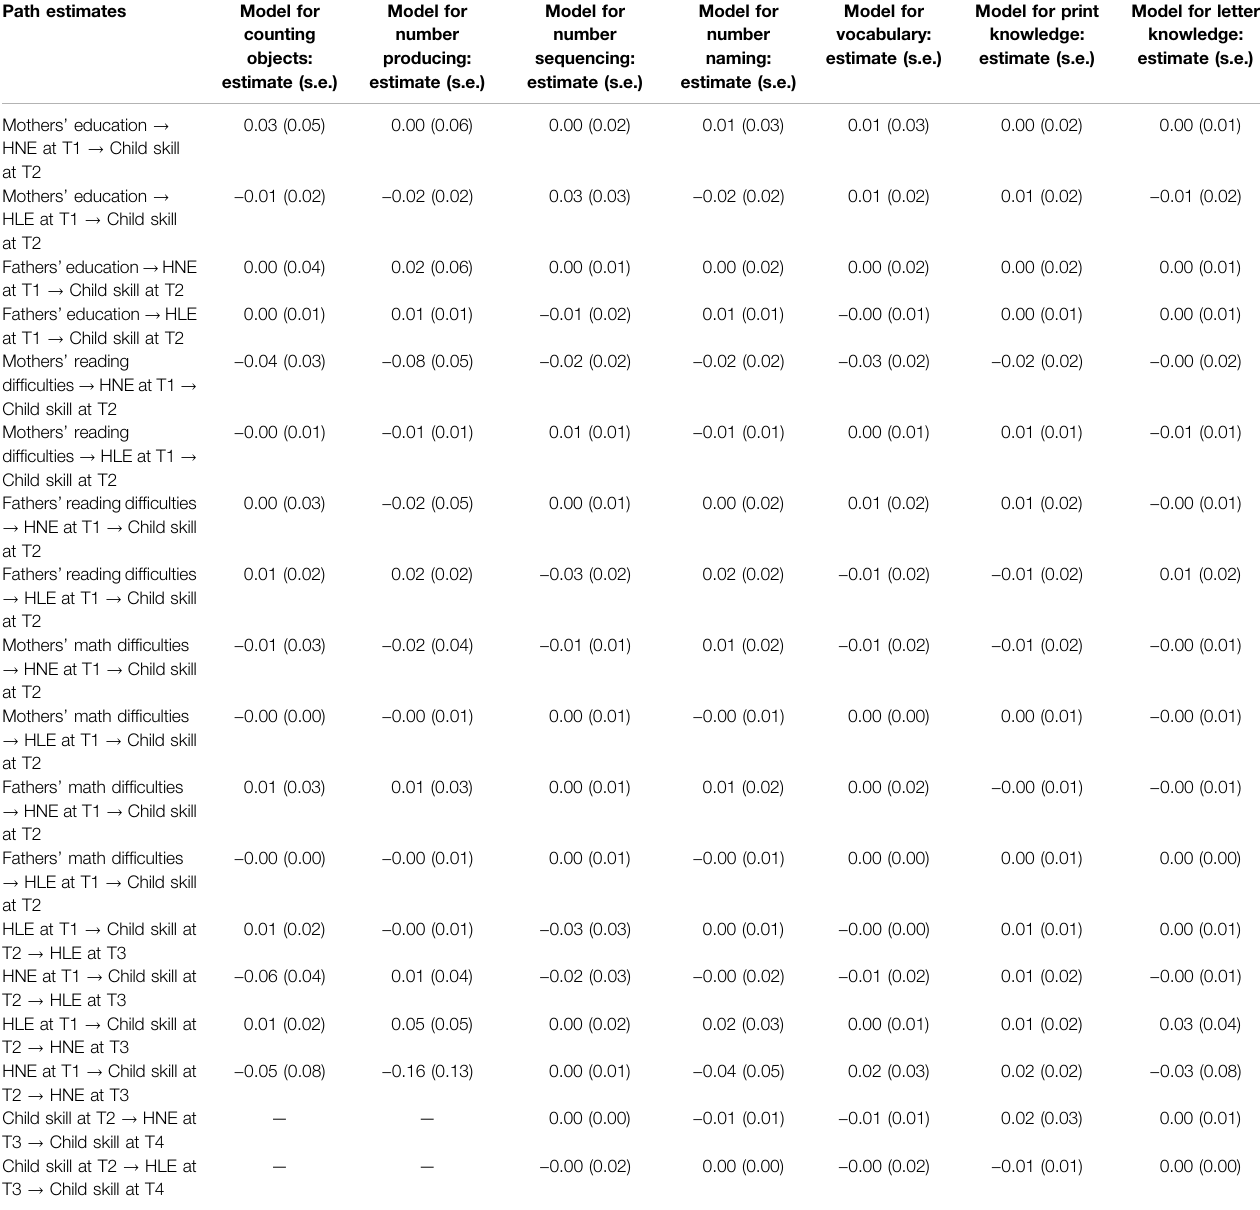
TABLE 5 | All indirect paths for models provided in Figures 4 – 11 (mediation analysis